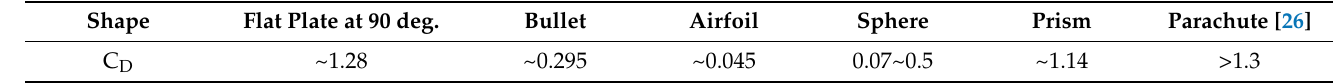
Table 2. Shape effects on drag